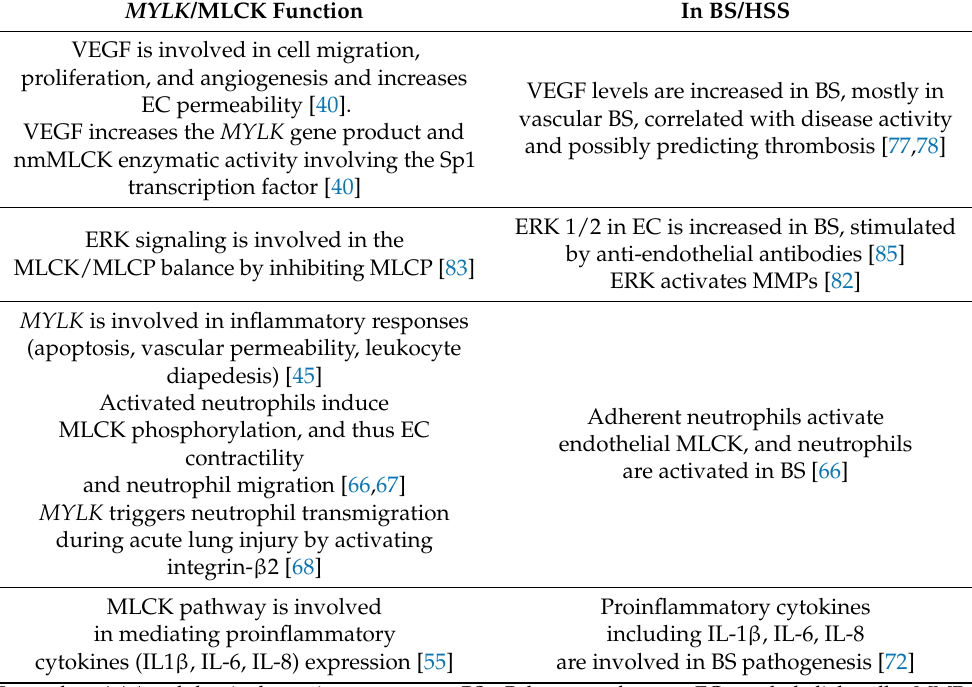
Table 1. Cont. MYLK /MLCK Function In BS/HSS VEGF is involved in cell migration, proliferation, and angiogenesis and increases EC permeability